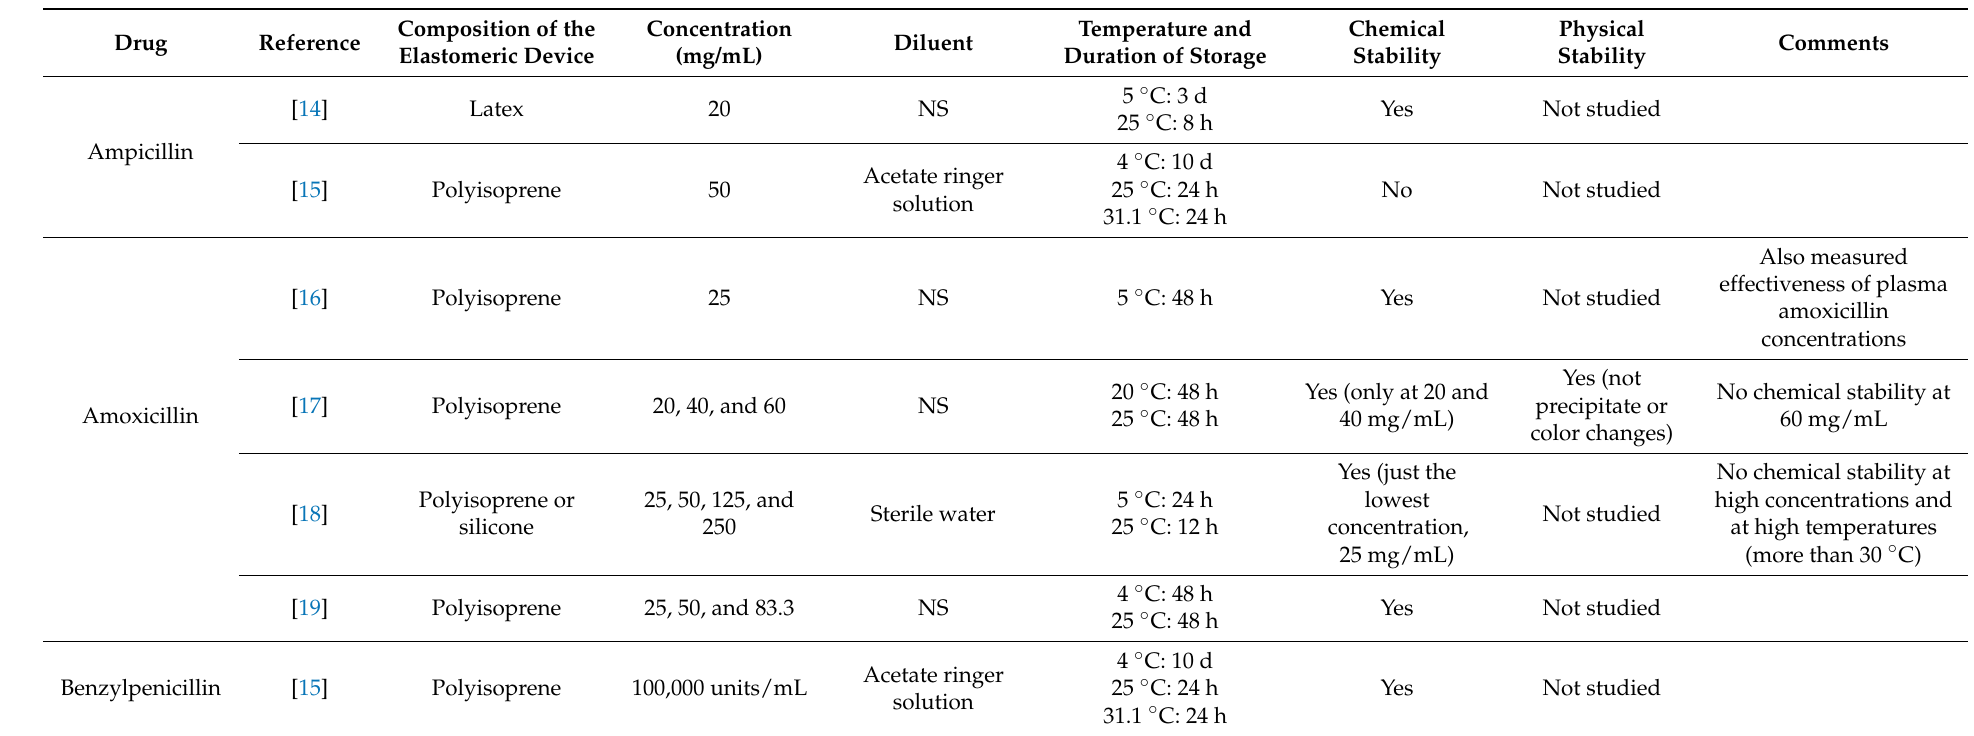
Table 1. Stability of penicillins in elastomeric